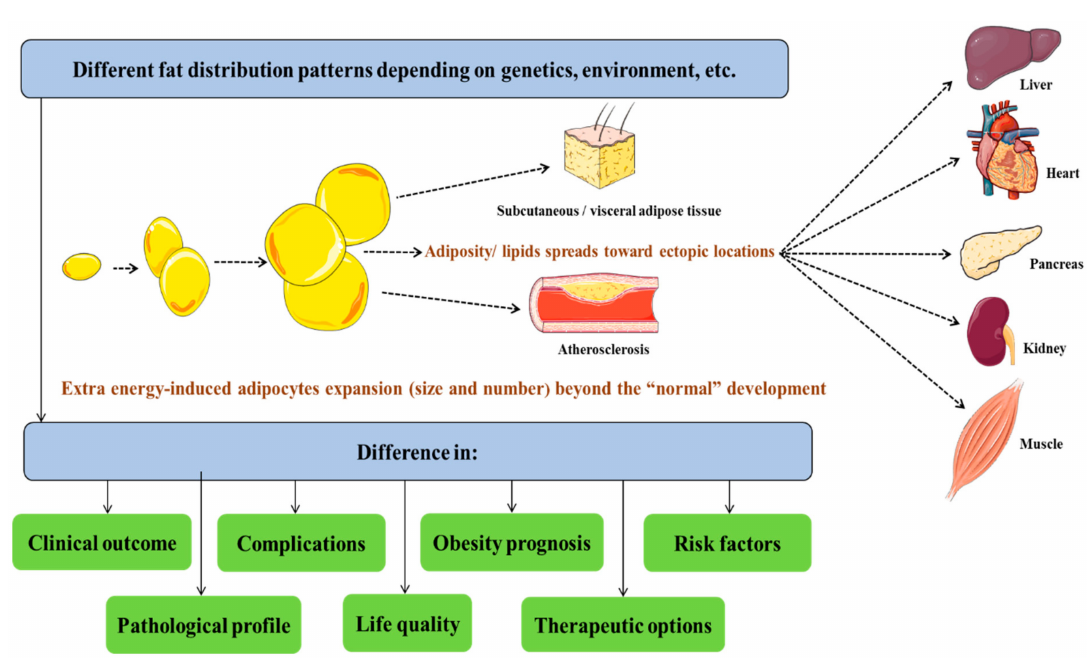
Figure 1. Different fat distribution patterns with diverse